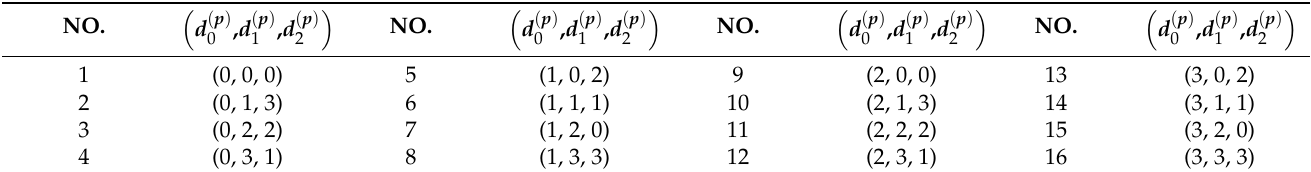
( p ) = 0 ( mod 4 ) + d ( p ) + d ( p ) 2 0 1